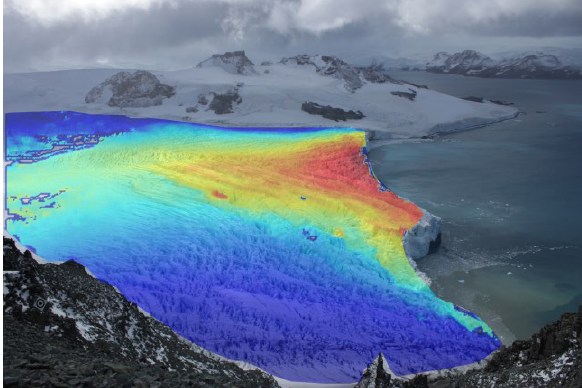
Figure 5: Velocity field obtained from one camera (color code  Fig.